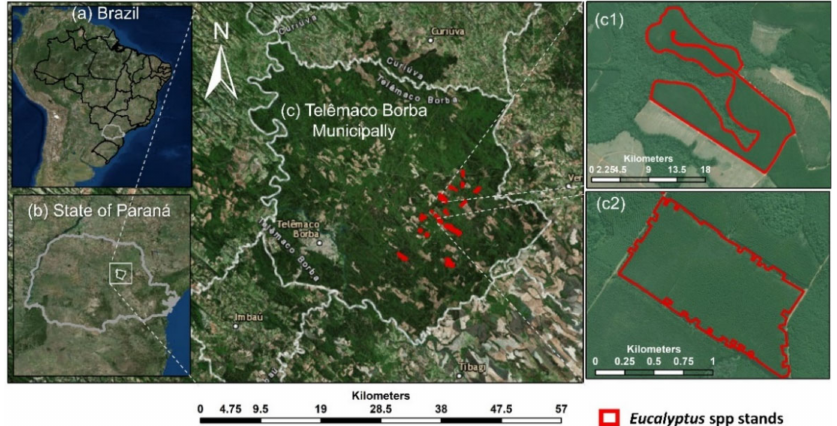
Figure 1. The study site location. ( a ) Brazil, ( b ) State of Paran á , ( c ) Telemaco Borba Municipality, and ( c1 ) and ( c2 ) examples of Eucalyptus forest plantation